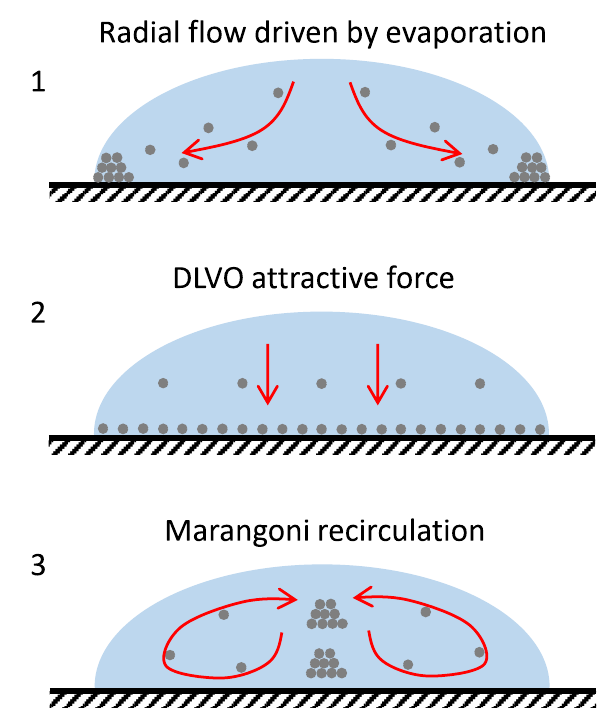
Figure 3. Three convective mechanisms compete to form the deposit. In (1), a ring forms due to radial flow caused by a maximum evaporation rate at the pinned wetting line; in (2), a uniform deposit forms due to an attractive Derjaguin-Landau-Verwey-Overbeek (DLVO) force between the particles and the substrate; in (3), a central bump forms due to a Marangoni recirculation loop [120]. As for droplet splashing, the parameter K is highly dependent on the viscosity and surface tension of the working fluid. It is thus mainly depending on the choice of